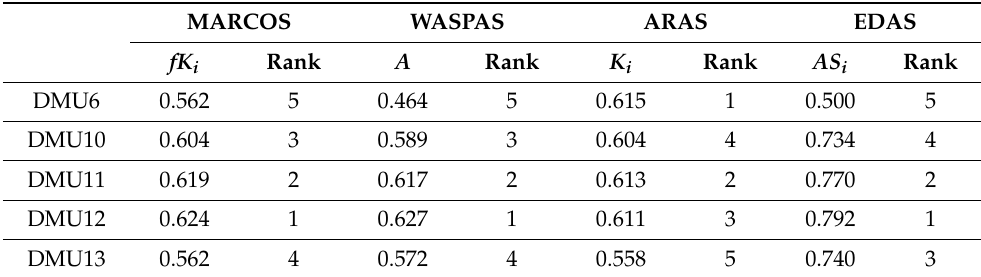
Table 9. Comparative analysis for both